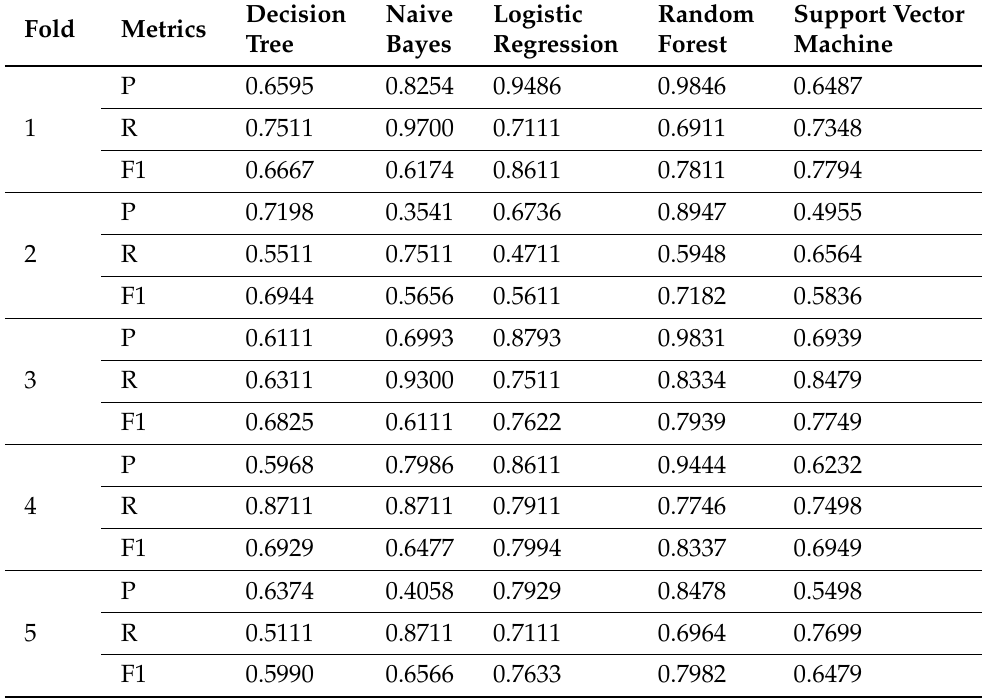
Table 6. Different classifiers’ performance evaluation for each